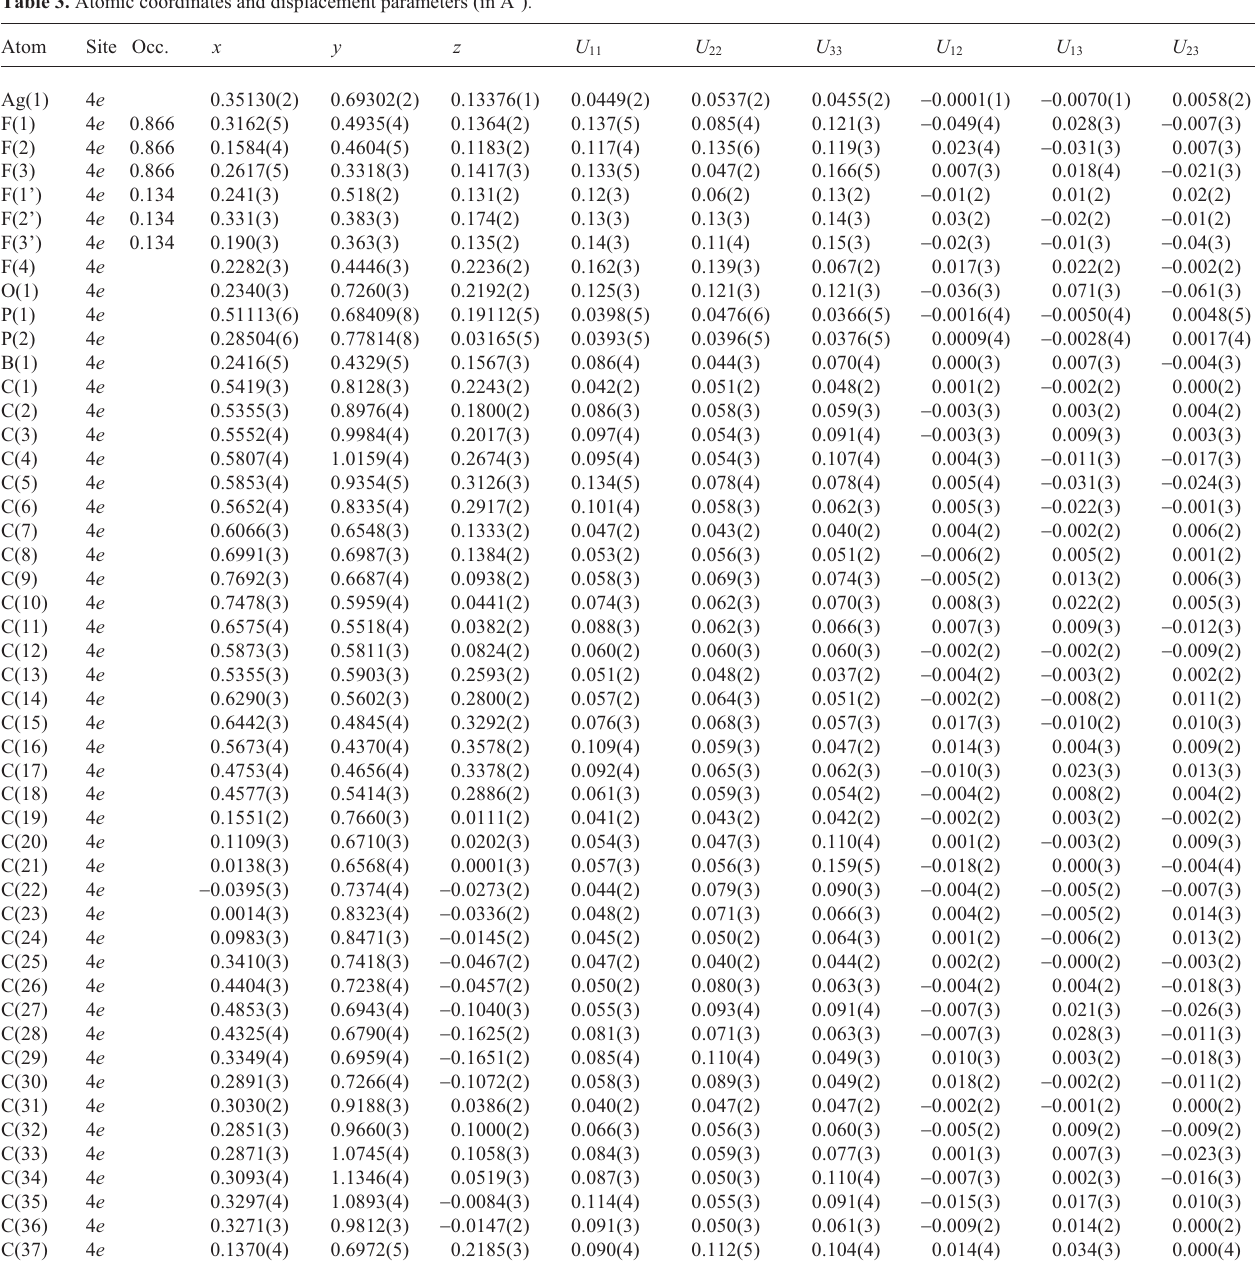
Table 3. Atomic coordinates and displacement parameters (in Å 2 )